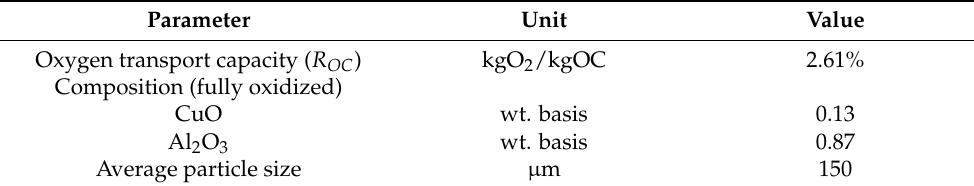
Table 3. OC characteristics. 𝑅 (cid:3016)(cid:3004) is expressed in kg of oxygen per kg of fully oxidized OC. Parameter